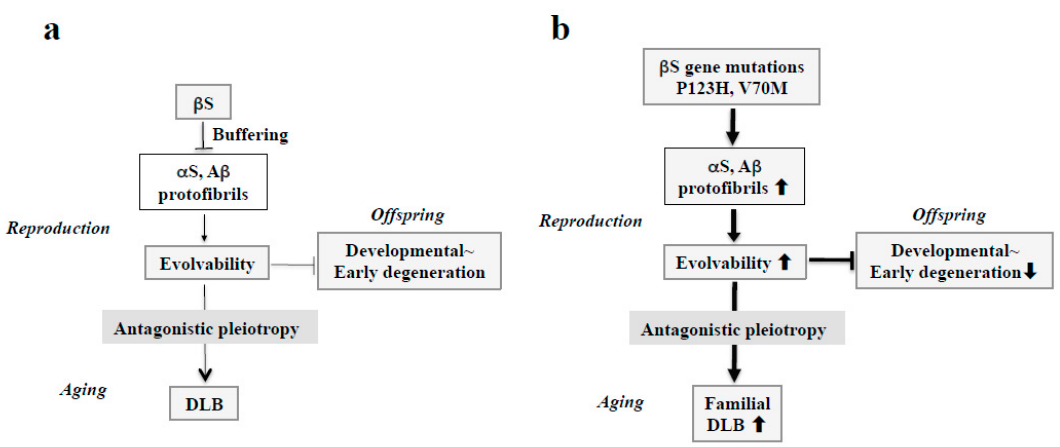
Figure 4. Schematics of the involvement of amyloidogenic evolvability in DLB. ( a ) Evolvability of APs, including α S and A β , may be an epigenetics to transmit stress information to o ff spring via germ cells. To regulate protein aggregation and amyloid neurotoxicity, β S may act as a bu ff er for this phenomenon. By virtue of this, o ff spring can cope with the forthcoming diverse stresses to be resistant against developmental~early degenerative diseases in o ff spring during the reproductive life stage. However, evolvability might become detrimental through the antagonistic pleiotropy mechanism during aging in parents, increasing the risk of DLB. ( b ) In familial DLB, β S gene mutations, including P123H and V70M, may stimulate aggregation of APs, including α S and A β . By virtue of the increased evolvability of APs, more information of stresses may be delivered from parents to o ff spring, which is beneficial for the o ff spring’s brain to avoid developmental~early degenerative diseases. On the other hand, increased activity of APs evolvability might be manifest as DLB through the antagonistic pleiotropy in parental